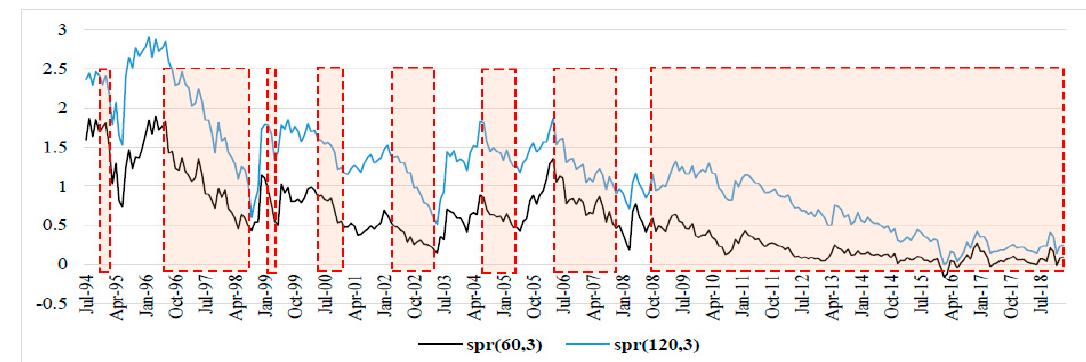
Figure 5. Yield spread-Japan.